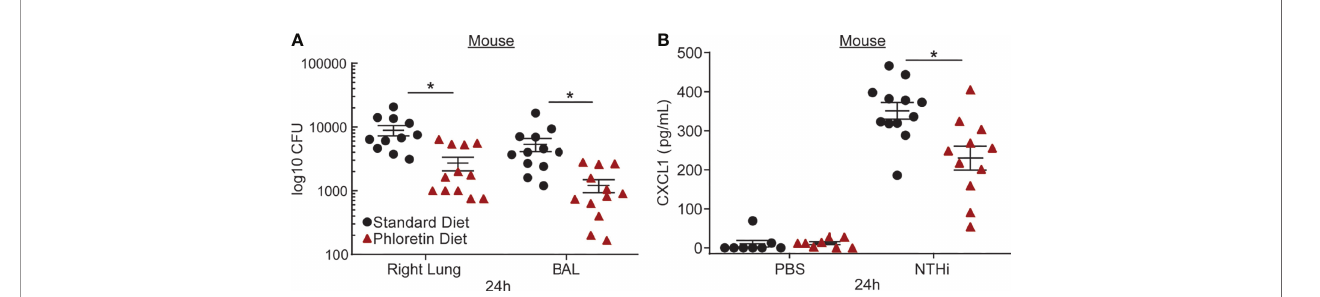
FIGURE 3 | Phloretin reduces nontypeable Haemophilus in fl uenzae (NTHi) burden and in fl ammation in mouse lungs. (A) Phloretin inhibits NTHi growth in mouse lungs. FVB/NJ mice (8 wks) were supplied with food pellets with or without phloretin supplementation ad libitum (0.157%, 1 wk) and exposed to NTHi (10 5 CFU, 24 h) intratracheally. Bacterial counts were measured in lung homogenate and BAL at 24 h. Results are the means ± SEM of 2 independent trials of 5-6 mice per condition tested within each trial ( n =11-12). *Signi fi cantly different from standard diet exposed mice ( P <0.05) as determined by unpaired t-test. (B) Phloretin inhibits C-X-C motif chemokine ligand 1 (CXCL1) protein, a neutrophil chemoattractant, induced by NTHi in BAL fl uid. CXCL1 was measured in BAL fl uid with a Luminex assay. Results are means ± SEM ( n =8-12). P values were assessed by one-way ANOVA followed by Tukey ’ s multiple comparisons test to compare standard diet+PBS to standard diet+ NTHi treated mice and to compare standard diet to phloretin diet treated mice. *Signi fi cantly different from standard diet treated mice (